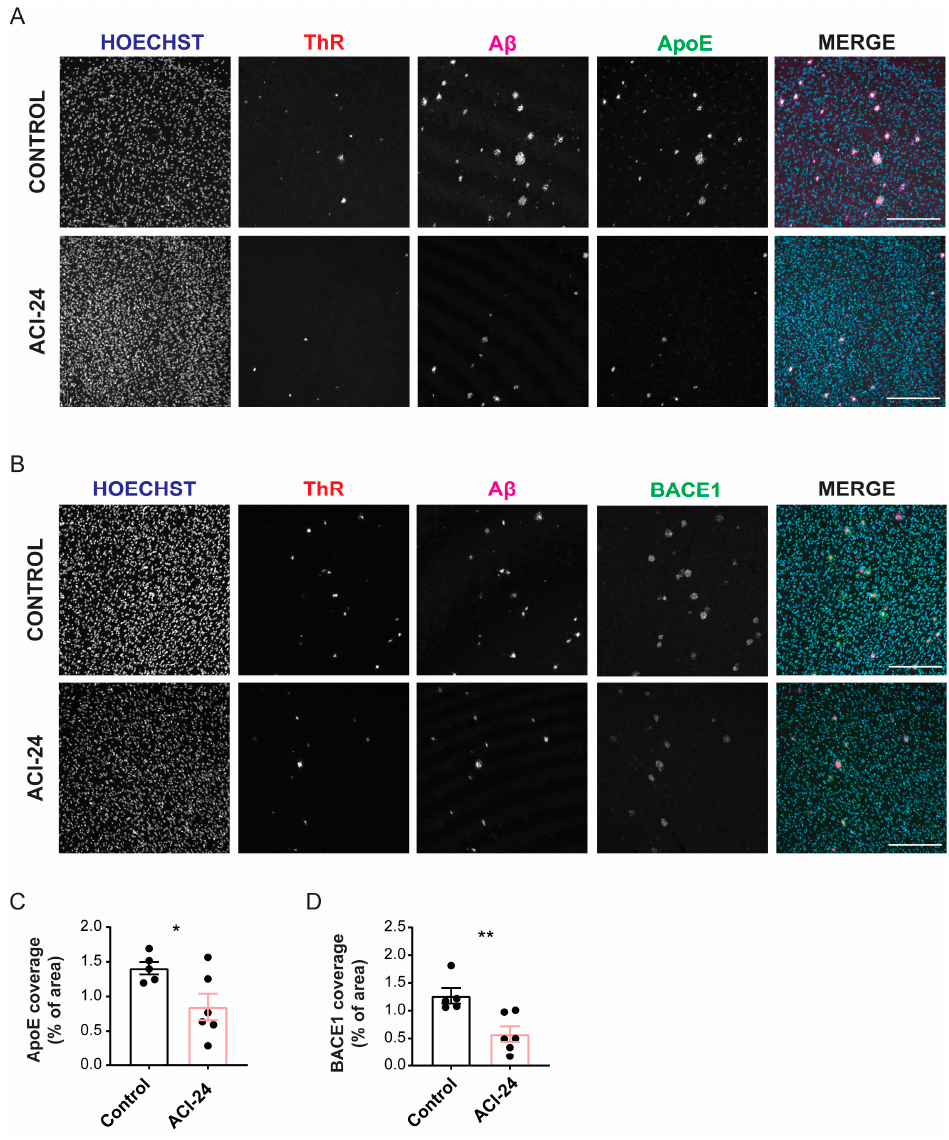
Figure 6. ACI-24 reduces ApoE protein levels and neuronal injury in the offspring generated by the transgenic mother. Representative images of control and ACI-24 vaccinated mice stained for nuclei (Hoechst), fibrillar A β (ThR), A β plaques (3552 antibody) and ApoE ( A ); and nuclei (Hoechst), fibrillar A β (ThR), A β plaques (NAB228 antibody) and BACE1 (dystrophic neurites) ( B ). Scale bar: 200 µ m. Statistical analysis of 5 control and 6 ACI-24 vaccinated mice (transgenic mother offspring) showing significant downregulation of both total ApoE ( C ) and BACE1 ( D ) coverage. Graphs are presented as mean ± SEM (* p < 0.05, ** p < 0.001, unpaired two-tailed Student’s t